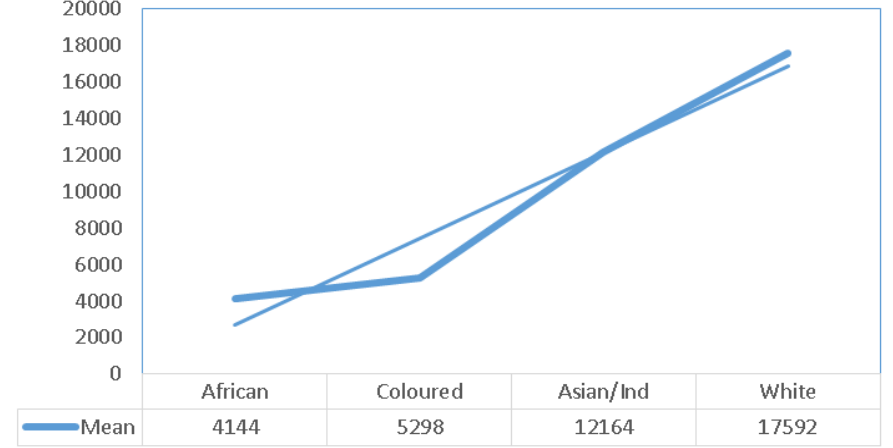
Fig. 2. Average wage by race in South Africa (2008-2012)